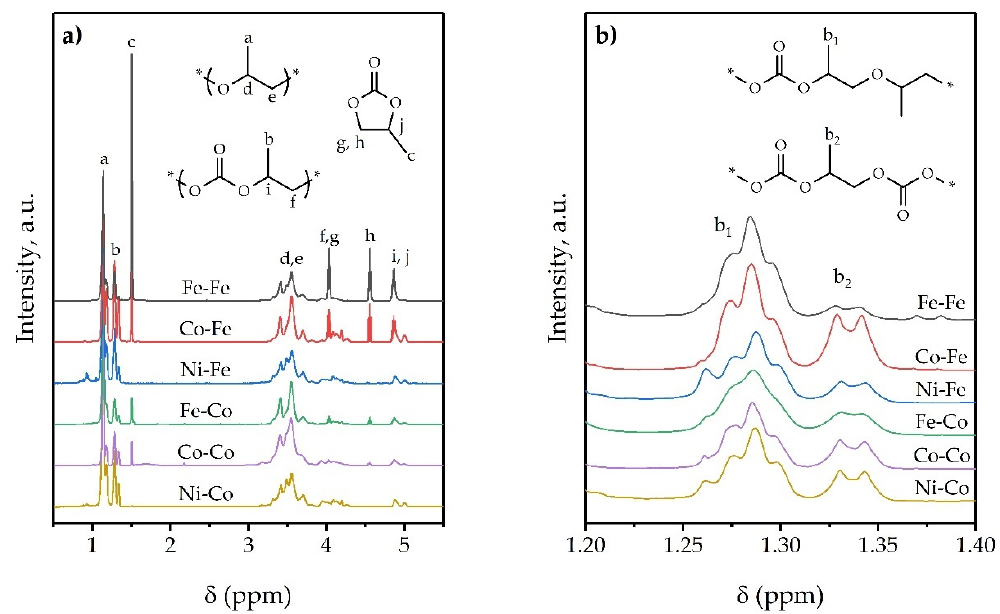
Figure 11. 1 H-NMR spectra of the obtained products ( a ) in the region from 0.5 to 5.5 ppm and ( b ) in the region corresponding to methyl entities of carbonate units (1.2–1.4 ppm). Peak assignment was made based on [91,92]. Detailed 1 H-NMR spectra of products are provided in Supplementary Materials (Figures S7–S12).